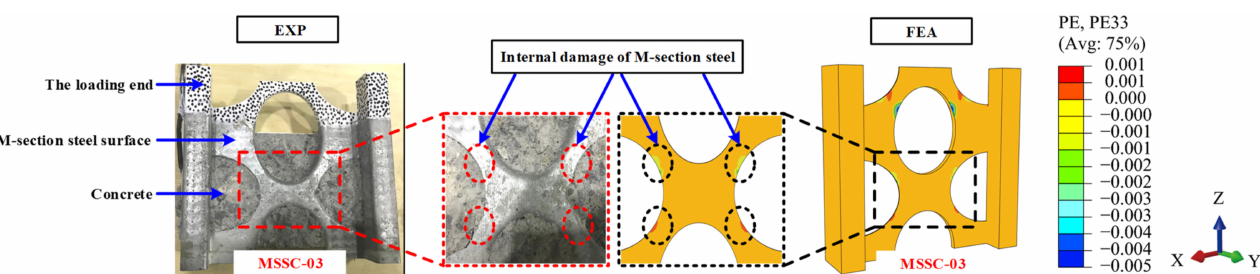
Figure 23. Internal failure mode comparison of M-section steel for specimen